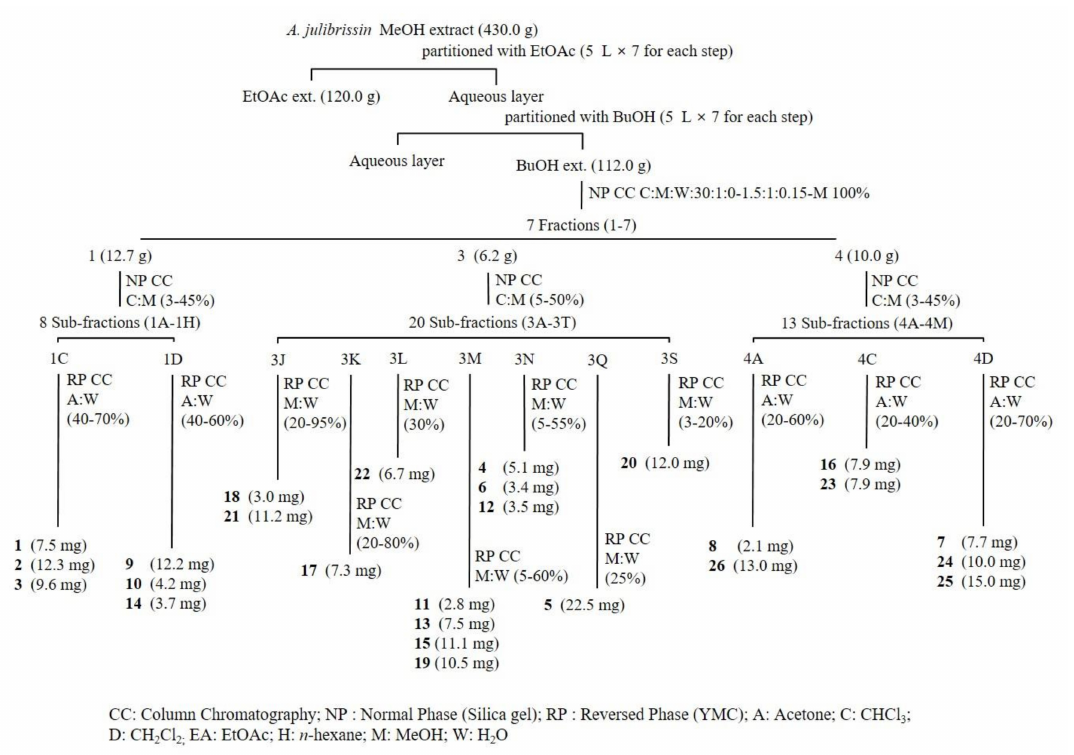
Figure 1. Schematic diagram displaying the process of isolation of compounds 1 – 26 from Albizzia julibrissin .